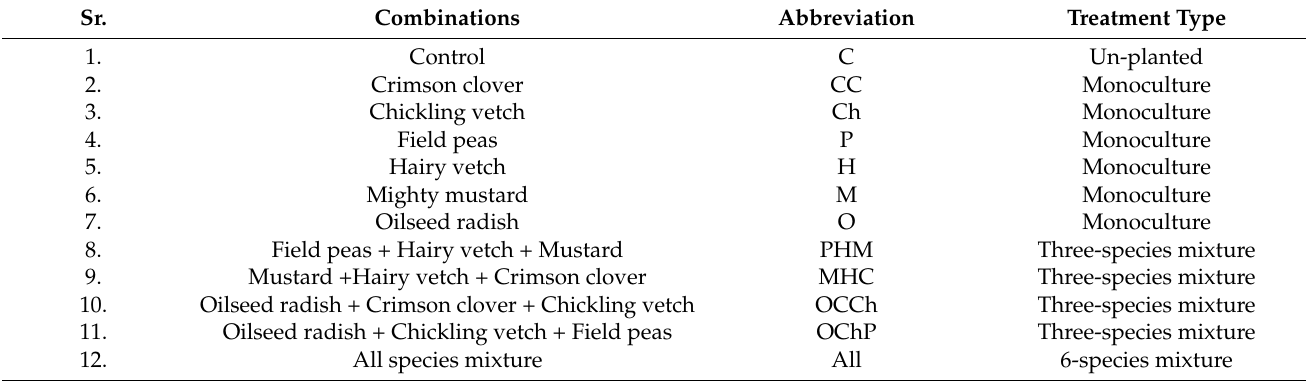
Table 1. An overview of cover crop species monoculture and mixture